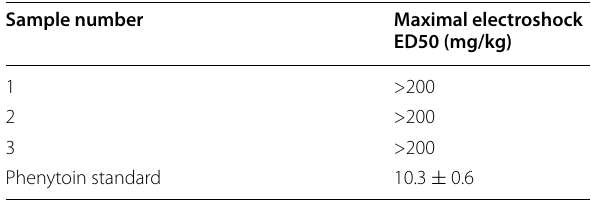
Table 3 Quantitative anticonvulsant data for mice using maximal electroshock